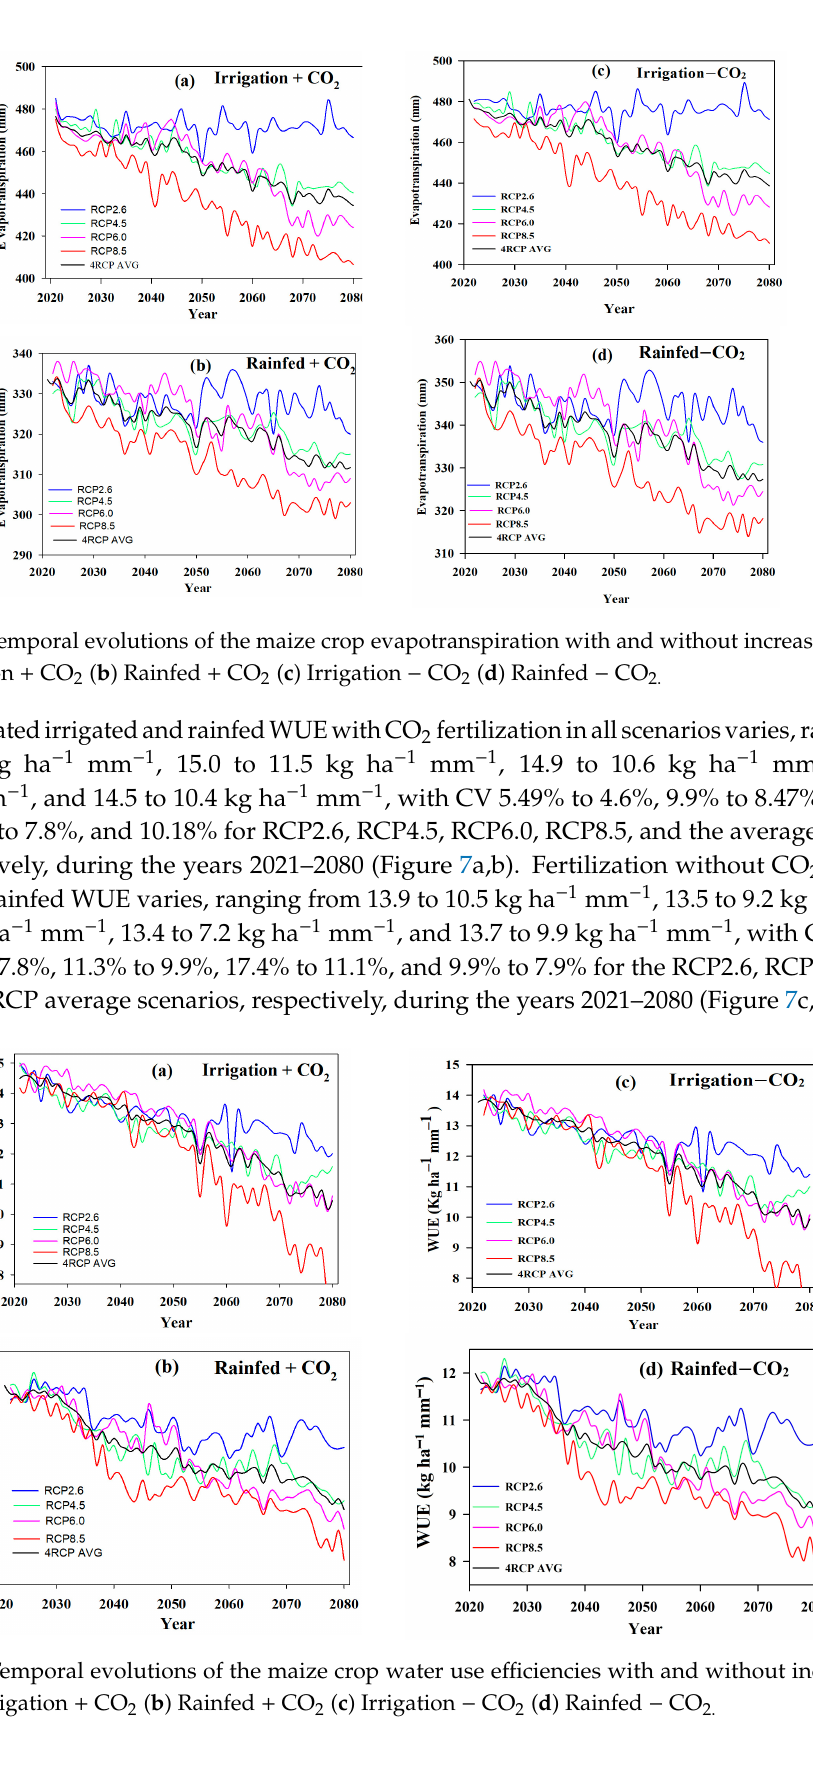
Figure 5. Temporal evolutions of the maize crop yields, with and without increased CO 2. ( a ) Irrigated + CO 2 ( b ) Rainfed + CO 2 ( c ) Irrigation − CO 2 ( d ) Rainfed − CO 2. The simulated irrigated and rainfed evapotranspiration with CO 2 fertilization in all scenarios varies, ranging from 485 to 320 mm, 480 to 312 mm, 483 to 306 mm, 475 to 299 mm, and 476 to 311 mm, with the CV from 1.23% to 1.96%, 1.77% to 2.55%, 3.81% to 3.05%, 4.51% to 2.95%, and 2.63% to